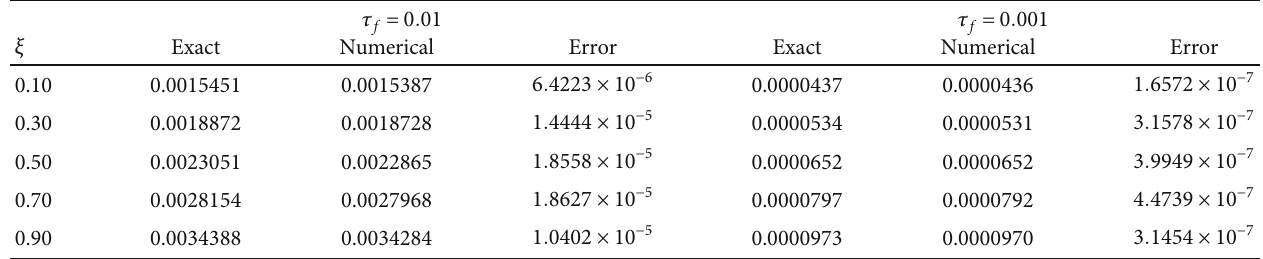
= 0 : 5 , and α = 0 : 7 1 2